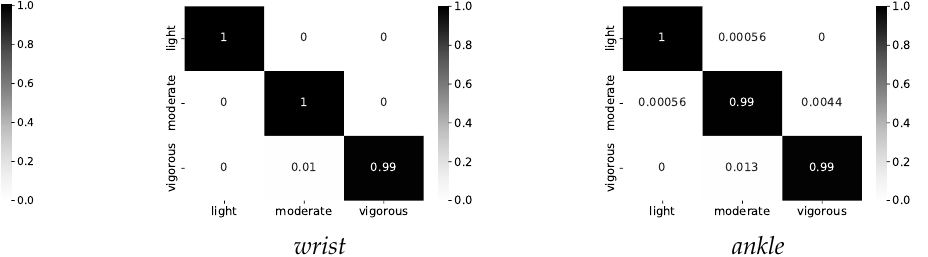
Figure 9. Confusion matrices of feature fusion for all three combinations. If we look at the chest and wrist sensor fusion, we can notice an accuracy of 94% among light-intensity activities (standing, sitting, and lying). Combining features from the wrist- and ankle-worn sensors, an accuracy of 99% was achieved for moderate-intensity activities (walking, climbing stairs, and cycling). Combining the chest and ankle sensors, an accuracy of 92% was achieved for vigorous-intensity activities (jogging and running). Further, we considered the detection of the intensity of activities, and based on this knowledge, the appropriate sensors were selected for the feature fusion. Therefore, on the first layer of activity recognition, we used a decision tree (DT) classifier based on the J48 model to recognize the intensity of the activity. Almost identical accuracy was obtained from the KNN model, but we chose the DT because of the run-time cost compared to the KNN, which uses more run-time resources. In this step, we reduced the sliding window to 1 s, which was sufficient for a very good classification. The best accuracy was obtained from the magnitude vector with only four features ( mad , var , rms , and iqr ). Furthermore, a very good performance can be obtained from any of the three sensors, as can be seen in Figure 10.